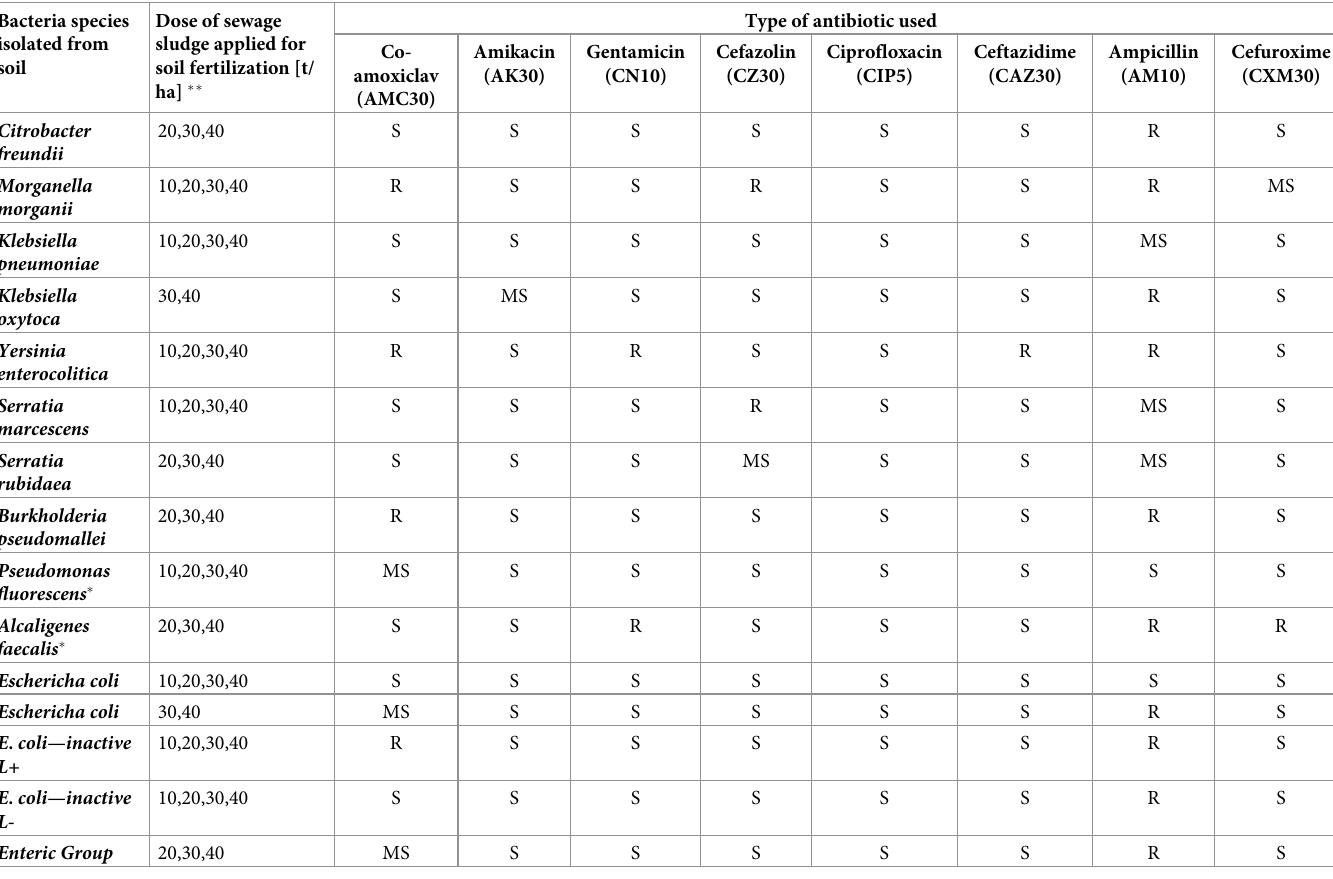
Symbols used for susceptibility of bacteria to antibiotics: S—susceptible, MS—medium susceptible, R—resistant. � species that are typically saprophytic in the environment.